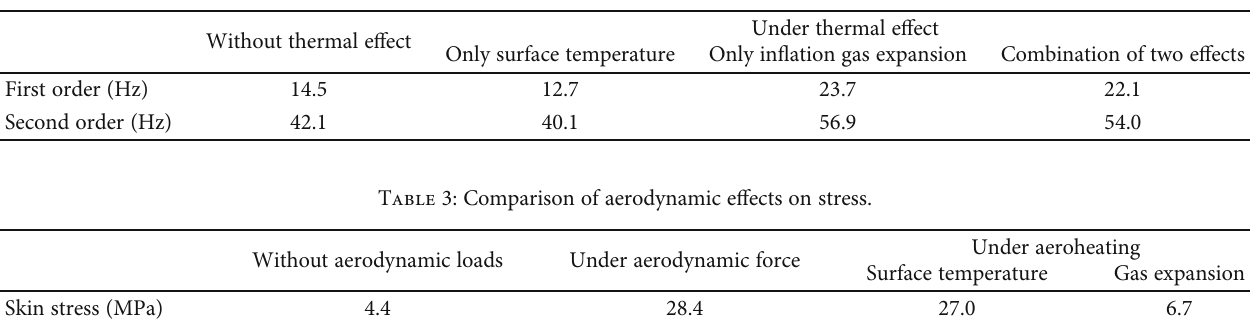
Figure 18: Vibration and frequency spectrum of skin: (a) vibration; (b) frequency spectrum. Table 2: Comparison of thermal e ff ects on natural